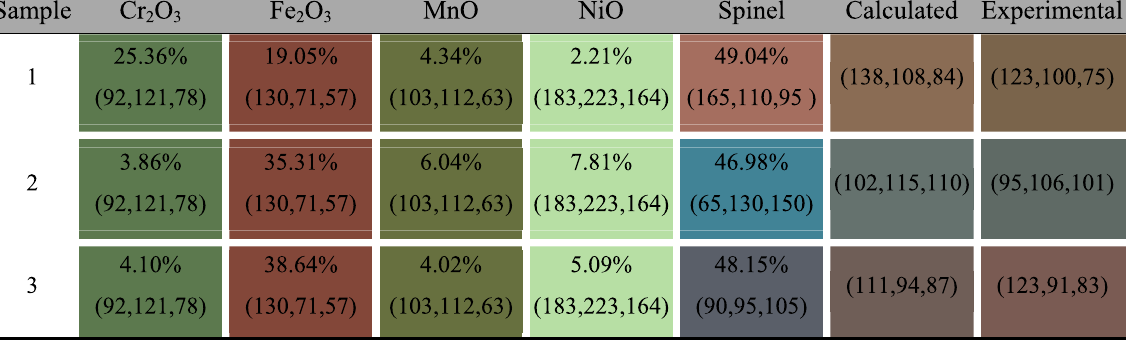
Table 2. Contents and color information of the compositions, and the calculated and measured RGB values of each sample. The percentage numbers show the contents of the composition. Each cell is shaded with its own RGB